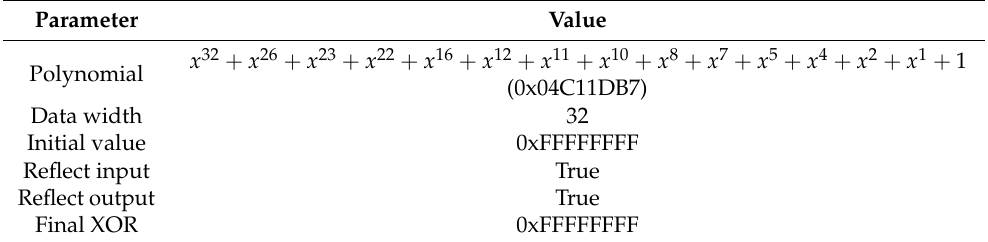
Table 1. The network probe hardware accelerator CRC-32’s implementation parameters, following [26].